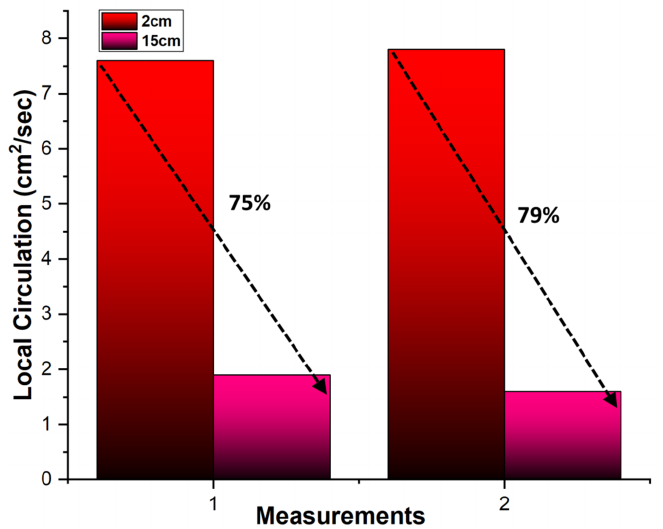
Figure 4. Comparison of local circulations at different locations along the axial axis.